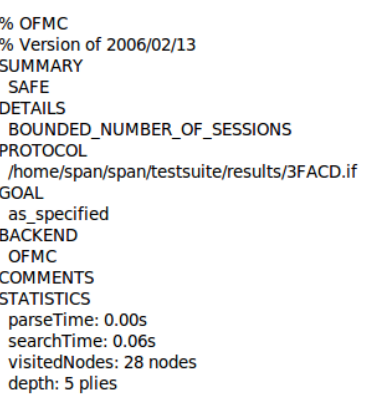
Figure 11. The simulation result using OFMC back-end.